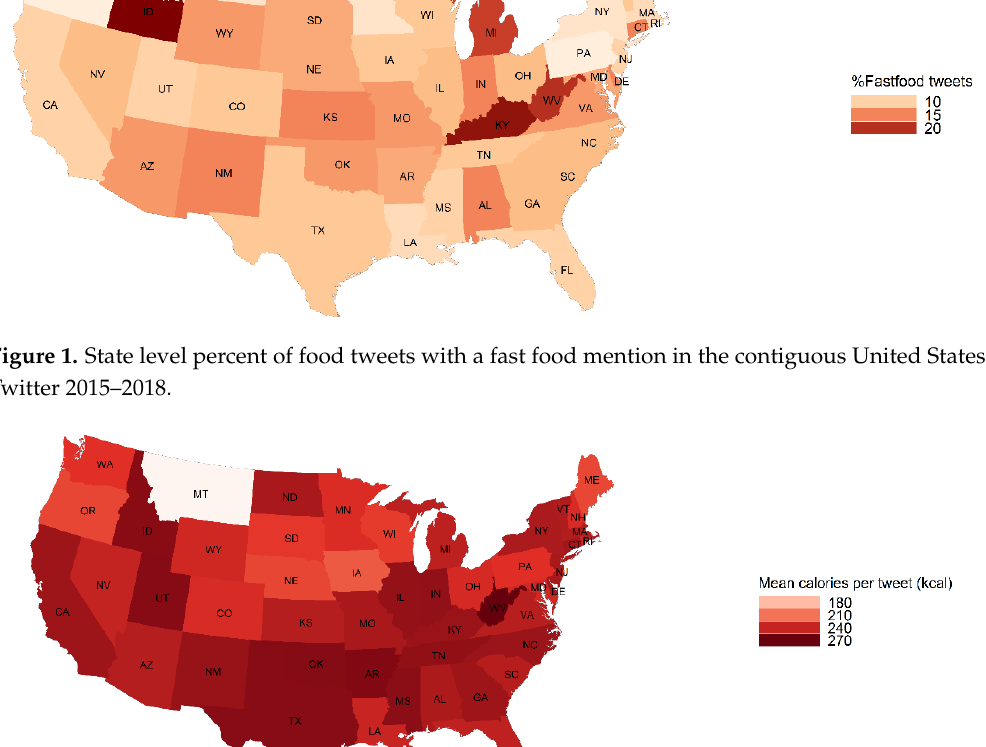
Figure 2. State level average caloric density per food tweet in the contiguous United States, Twitter 2015–2018.